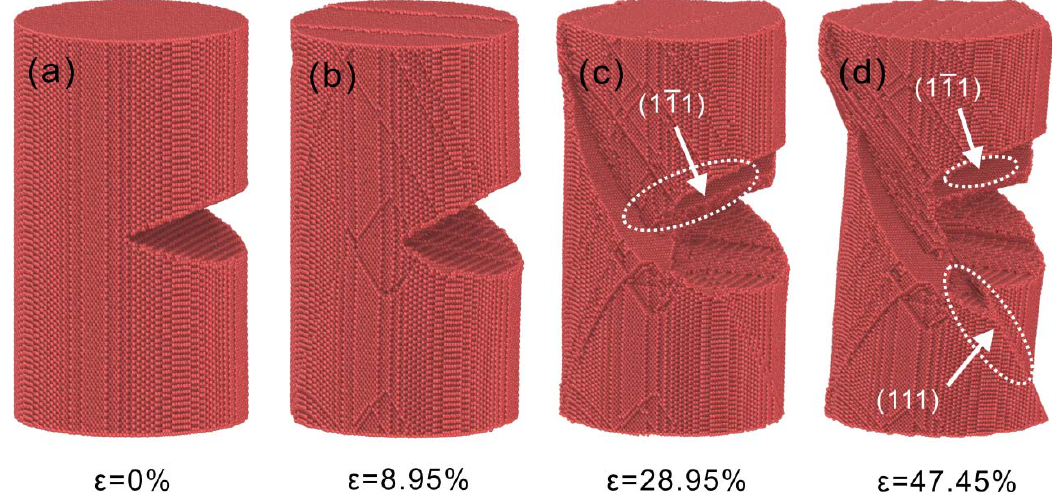
Figure 4. Microstructural evolution of Cu nanowires with 75 Å crack depth at 1 (cid:3400) 10 (cid:2876) s (cid:2879)(cid:2869) strain rate. ( a ) ε = 0%, ( b ) ε = 8.95%, ( c ) ε = 28.95%, ( d ) ε = 47.45%.